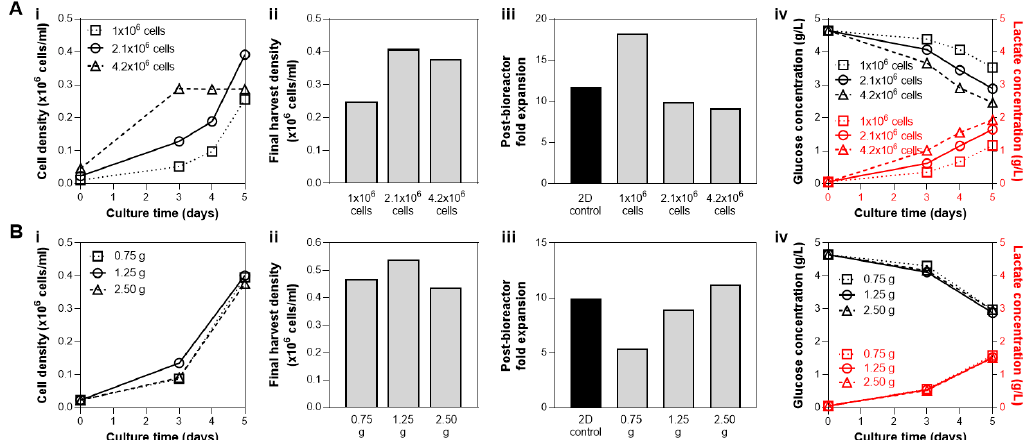
Figure 3. Optimization of bioreactor seeding parameters at fixed microcarrier amount (A; 1.25 g), or fixed cell number (B; 2.1 × 10 6 cells). ( A ) Effect of cell seeding numbers on bioreactor culture yield with